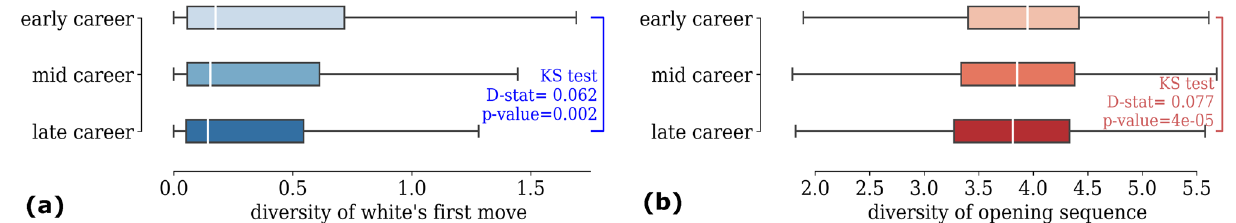
Figure 5. Diversity in opening with career stage. We show the diversity in the opening move ( a ) and opening sequence ( b ) of moves. In later parts of one’s career, diversity decreases, players prefer certain openings and specialize in them—playing them more